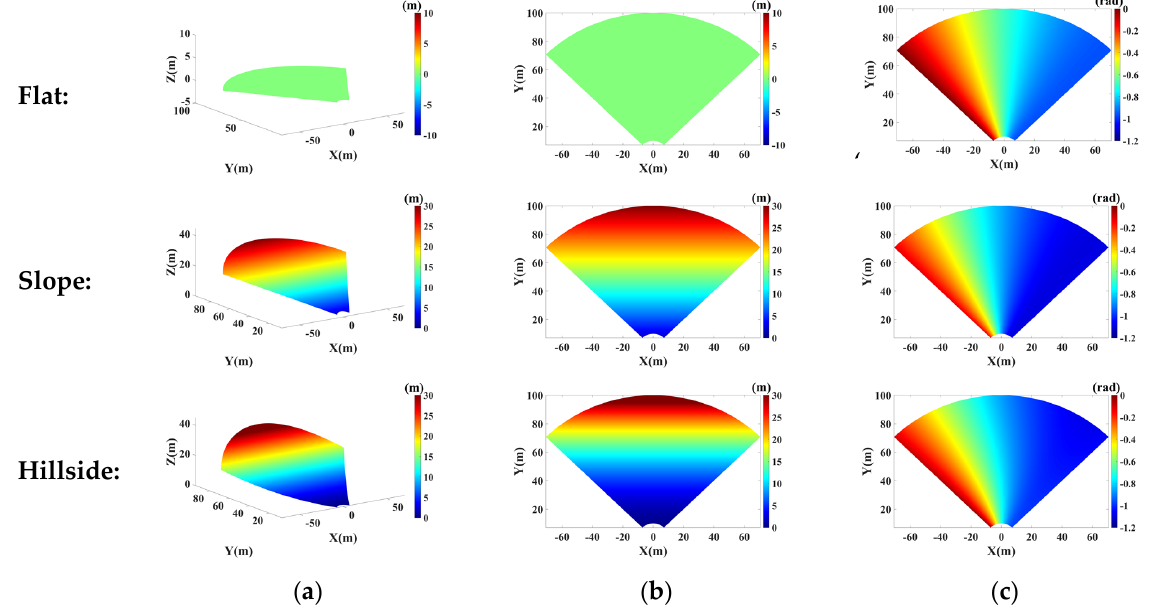
Figure 4. Simulation of repositioning errors with three different kinds of topographies ( ε x = ε y = ε z = 1 mm): ( a ) Topographies; ( b ) Elevations; ( c ) Repositioning error phase